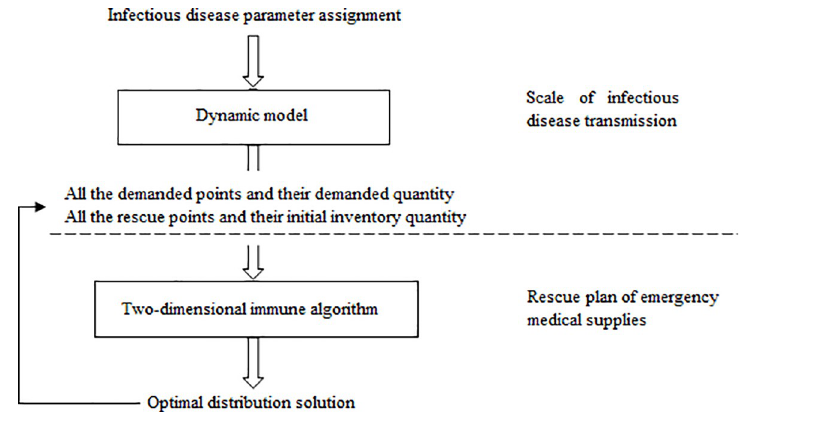
Fig 4. Model solution idea.